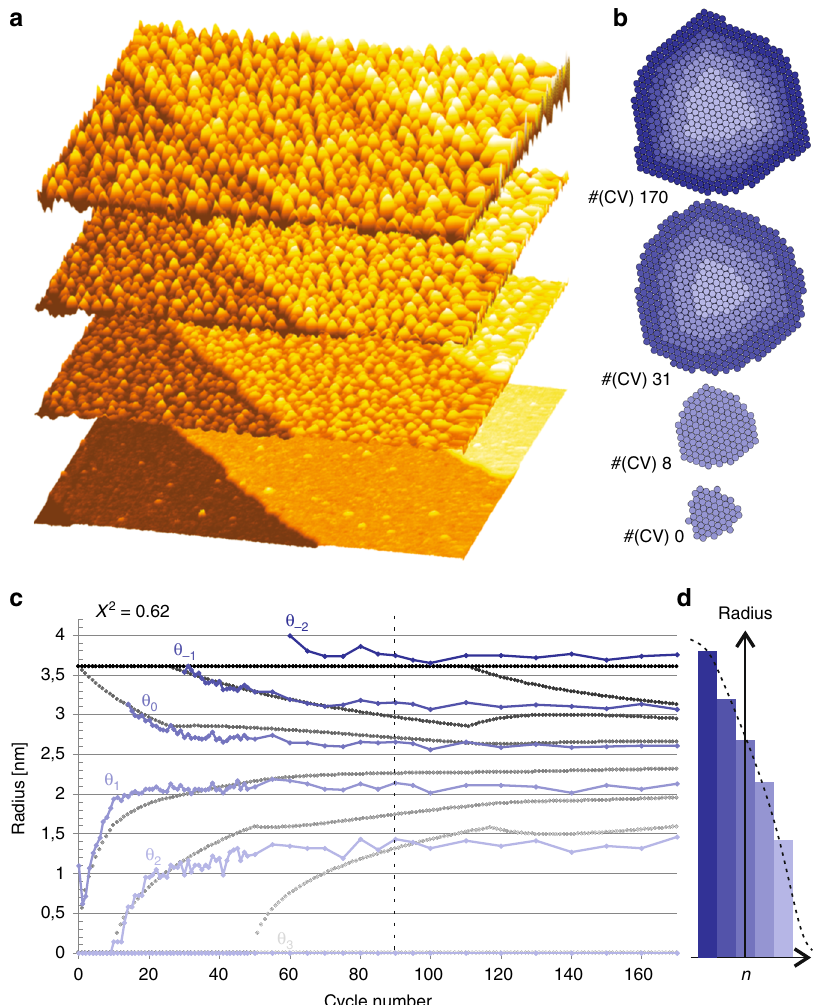
Fig. 5 Mound formation during combined vacancy and adatom creation: a nanoislands are formed during the electrochemical oxidation/reduction cycling on Pt(111) 30 ; b average, atomic island shape extracted from a , see ref. 35 ; c the evolution/growth of the individual atomic layers within the mounds, provided as radii in the graph, are obtained from the average island shape per cycle that typically takes into account a minimum of 400 islands 35 . The layers are indicated from light to dark blue. All corresponding gray lines are obtained by one single fi t of the theory with only four fi tting parameters, see text. d The island shape in layer fi lling representation at the moment of the dashed line in